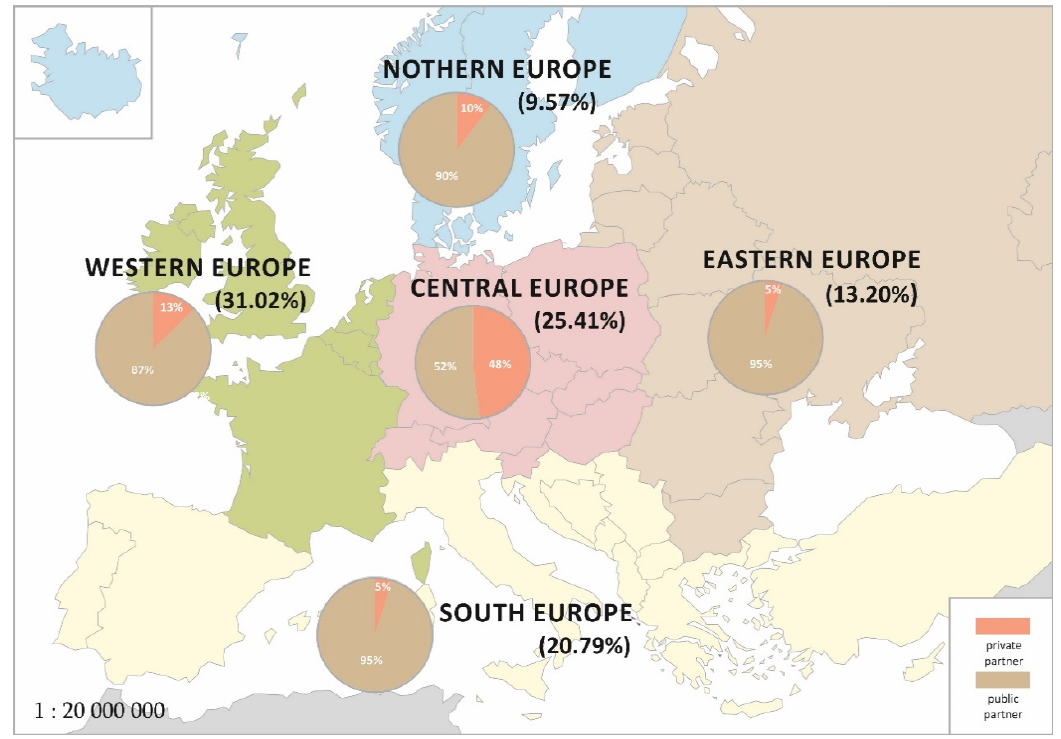
Figure 6. Structure of partners for events organized by the EEN in 2017–2018.